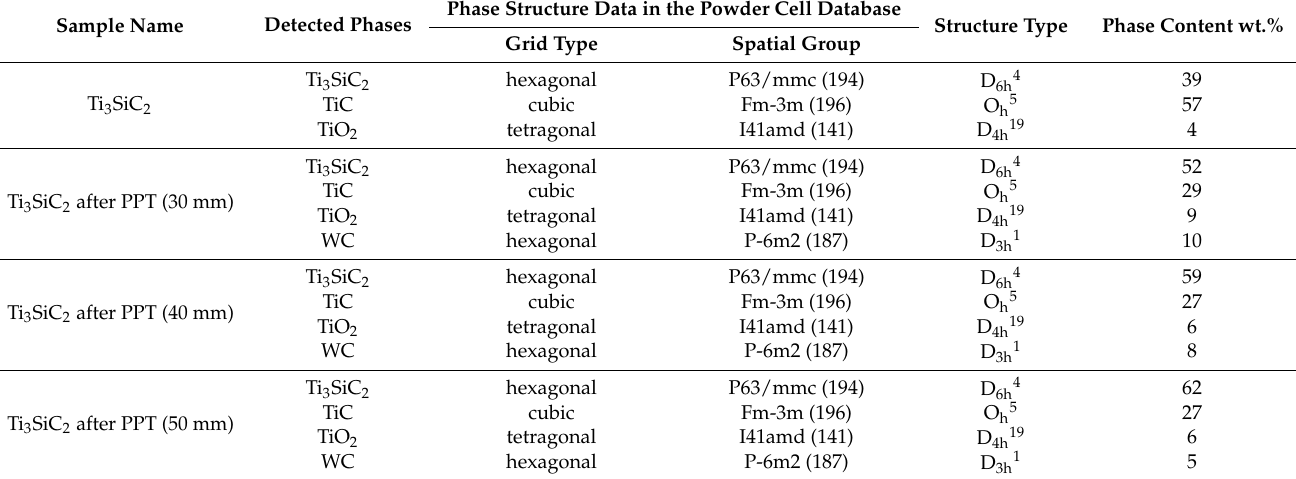
Figure 8. Diffractograms of detonation coatings based on Ti–Si–C before ( a ) and after pulsed-plasma treatment depending on the distance from the plasmatron: ( b ) 30 mm, ( c ) 40 mm, ( d ) 50 mm. Quantitative analyses were performed using PowderCell 2.4. Table 2 shows the data of X-ray phase analysis. Table 2. Results of X-ray phase